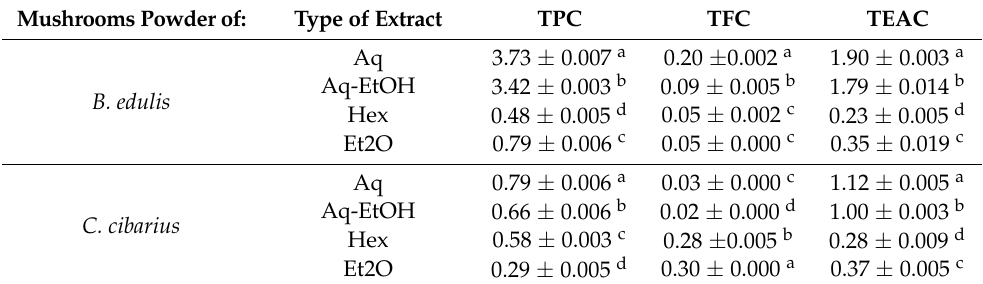
Table 1. Total phenolic contents (mg GAE/g dw), total flavonoid contents (TFC mg QUE/g dw), and antioxidant activities ( µ mol TE/g dw) of mushroom